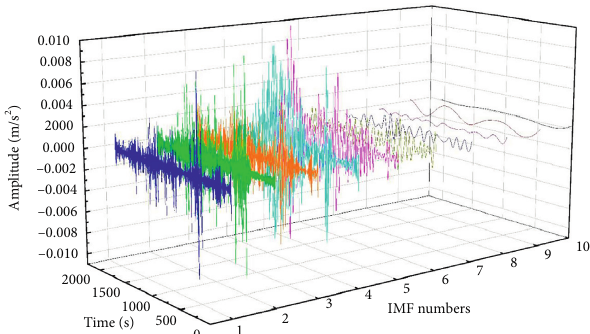
Figure 6: The ten IMFs got by the decomposition of UPEDM of the gearbox’s second working condition data.